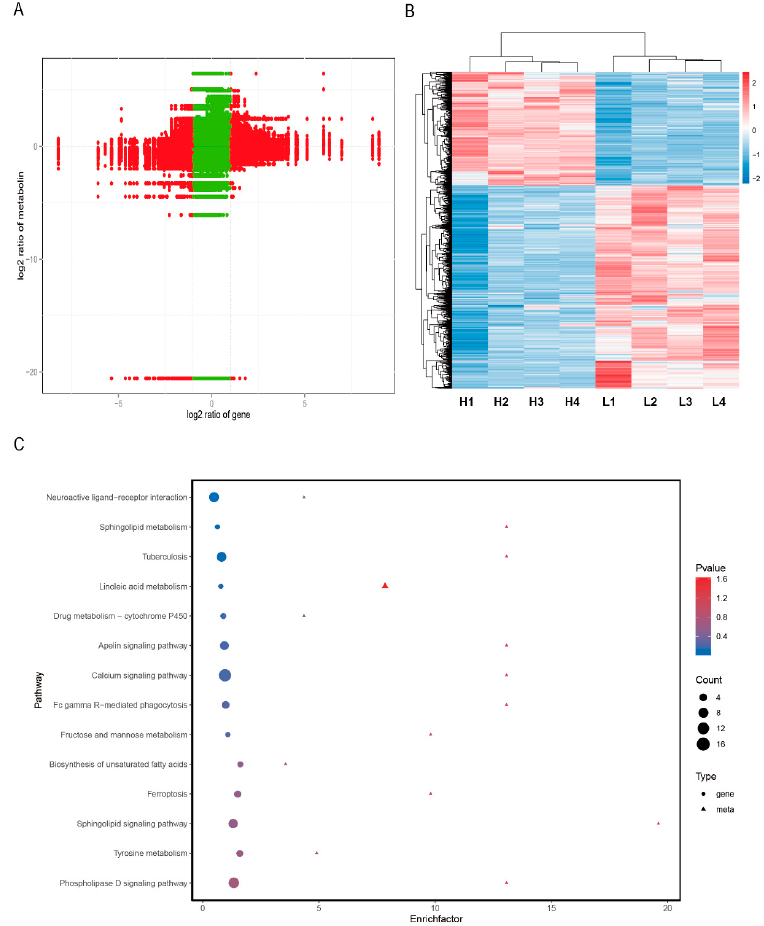
Figure 3. Combined metabolome and transcriptome analysis. ( A ) Nine-quadrant diagrams. The calculation of correlations between all genes and metabolites based on the Pearson correlation, with screening thresholds of |CC| > 0.80 and CCP < 0.05. Left-to-right and top-to-bo tt om indicates the order of quadrants 1 to 9. The 3rd and 7th quadrants represent the same trend of gene and metabo- lite expression, which indicate that the genes may be positively regulated metabolites. The 1st and 9th quadrants indicate that the genes and metabolites are negatively correlated. The 2nd and 8th represent not just the unchanged genes but also the up- and down-regulation of the metabolites. The 4th and 6th represent not just the unchanged metabolites but also the genes that were up-regu- lated. The 5th indicated no signi fi cant changes in both the metabolites and the genes. Only quad- rants 1, 2, 3, 7, 8, and 9 were involved in this analysis. ( B ) The correlation analysis hierarchical clus- tering heatmap. Each row of the hierarchical clustering heatmap represented one DEG or DEM for each column of that di ff erentially grouped sample. The clusters appear in the same cluster of signif- icantly di ff erent metabolites or di ff erential genes with similar expression pa tt erns. ( C ) The di ff eren- tial gene/metabolite KEGG enrichment bubble plot. The enrich factor represents the enrichment fac- tor of the pathway in di ff erent omics, and the ordinate represents the name of the KEGG pathway;